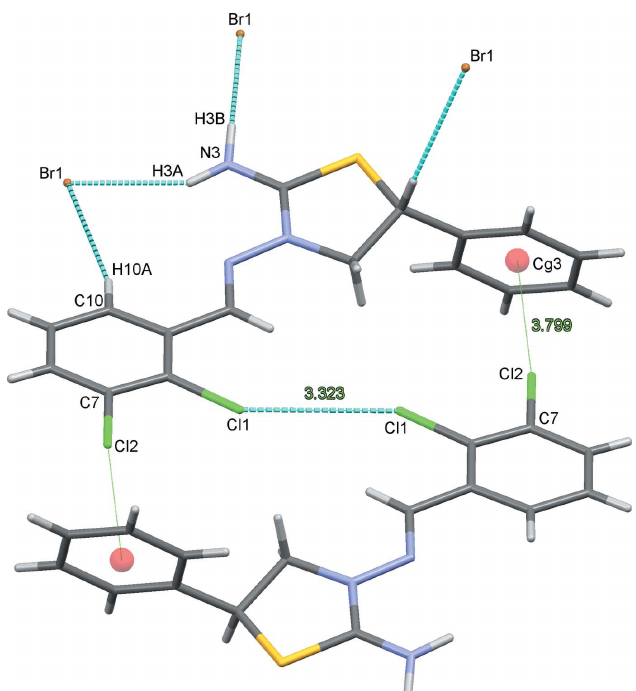
Figure 2 View of the full complement of contacts to an individual cation in the title salt. Only the major disorder component is shown. The symmetry- equivalent position for the cation with the label Cg 3 is (cid:3) x + 1, y (cid:3) 1 (cid:3) z + 3/2.